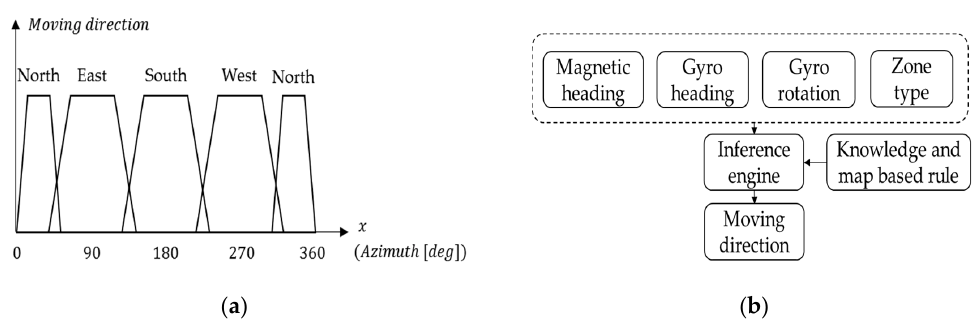
Figure 9. This figure shows the fuzzy system of the moving direction: ( a ) The membership function of moving direction; ( b ) The fuzzy system of moving direction with the input of four fuzzy sets. Table 2. The example of IF-THEN rules for the fuzzy system of next zone type.